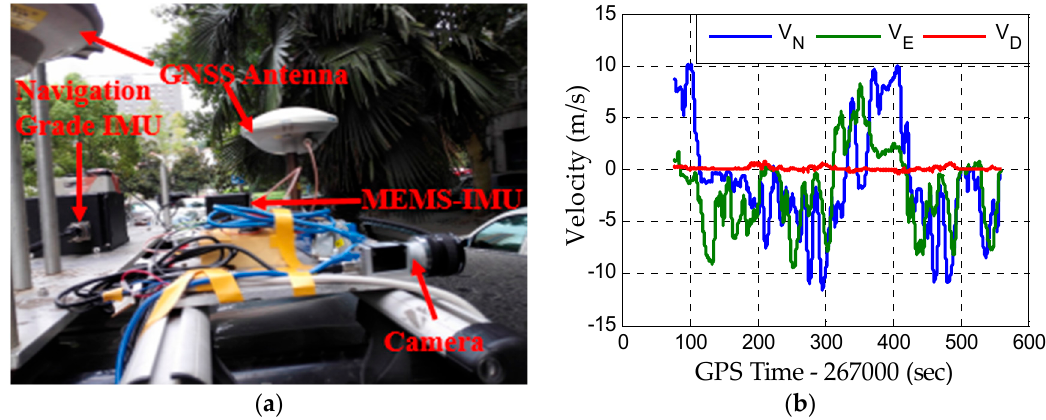
Figure 4. Test description. ( a ) Test platform and equipment; ( b ) Velocity of the vehicle. Table 1. Performance specifications of the IMU sensors in the experiment.